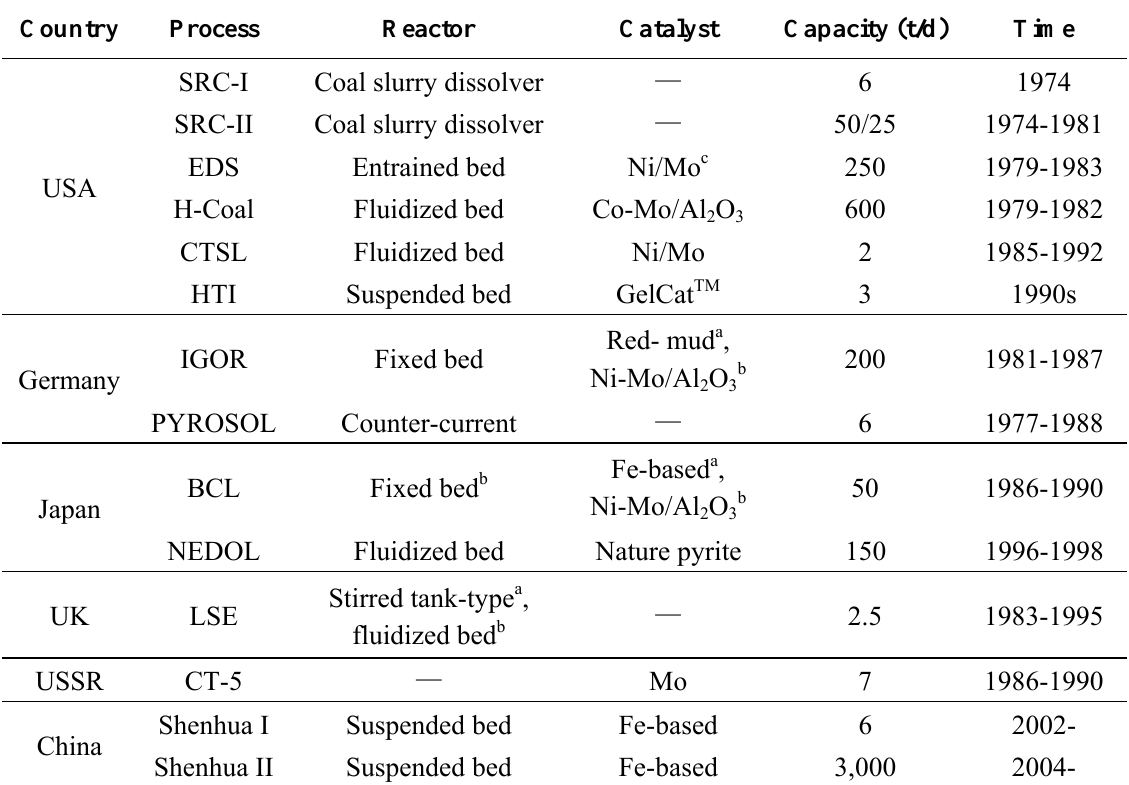
Table 1. Summary of major DCL processes developed around the world